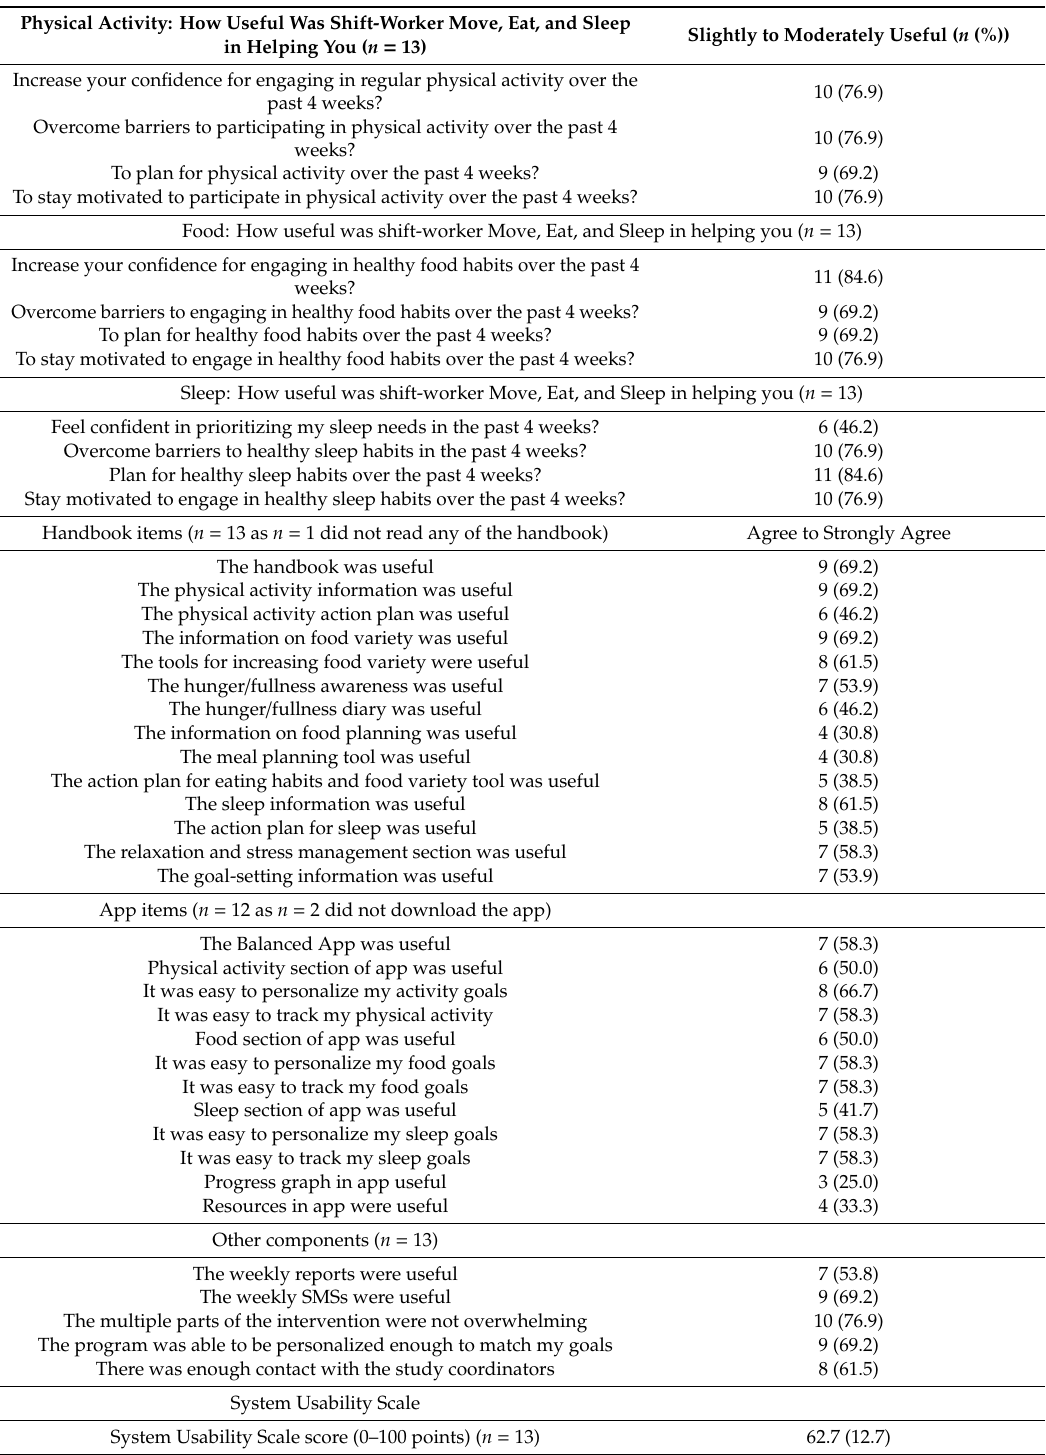
Table 3. Usefulness of shift-worker Move, Eat, and Sleep intervention overall ( n = 13, n = 1 did not access any of